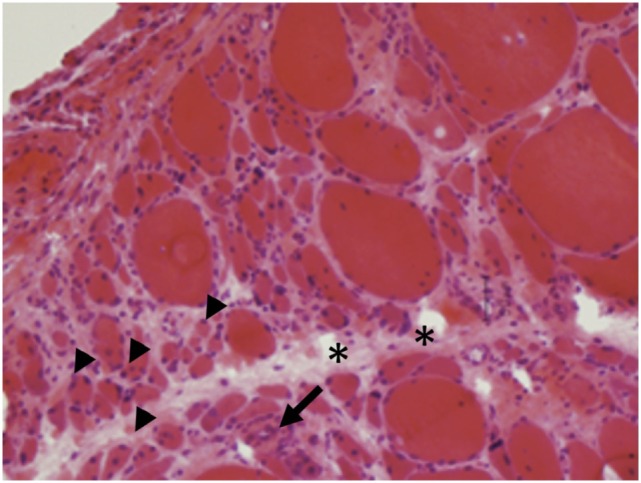
Perifascicular atrophy (arrowheads) with increased endomysial connective tissue (asterisks) and inflammatory infiltrates (arrows) are characteristics of dermatomyositis (A, H&E, 40×).